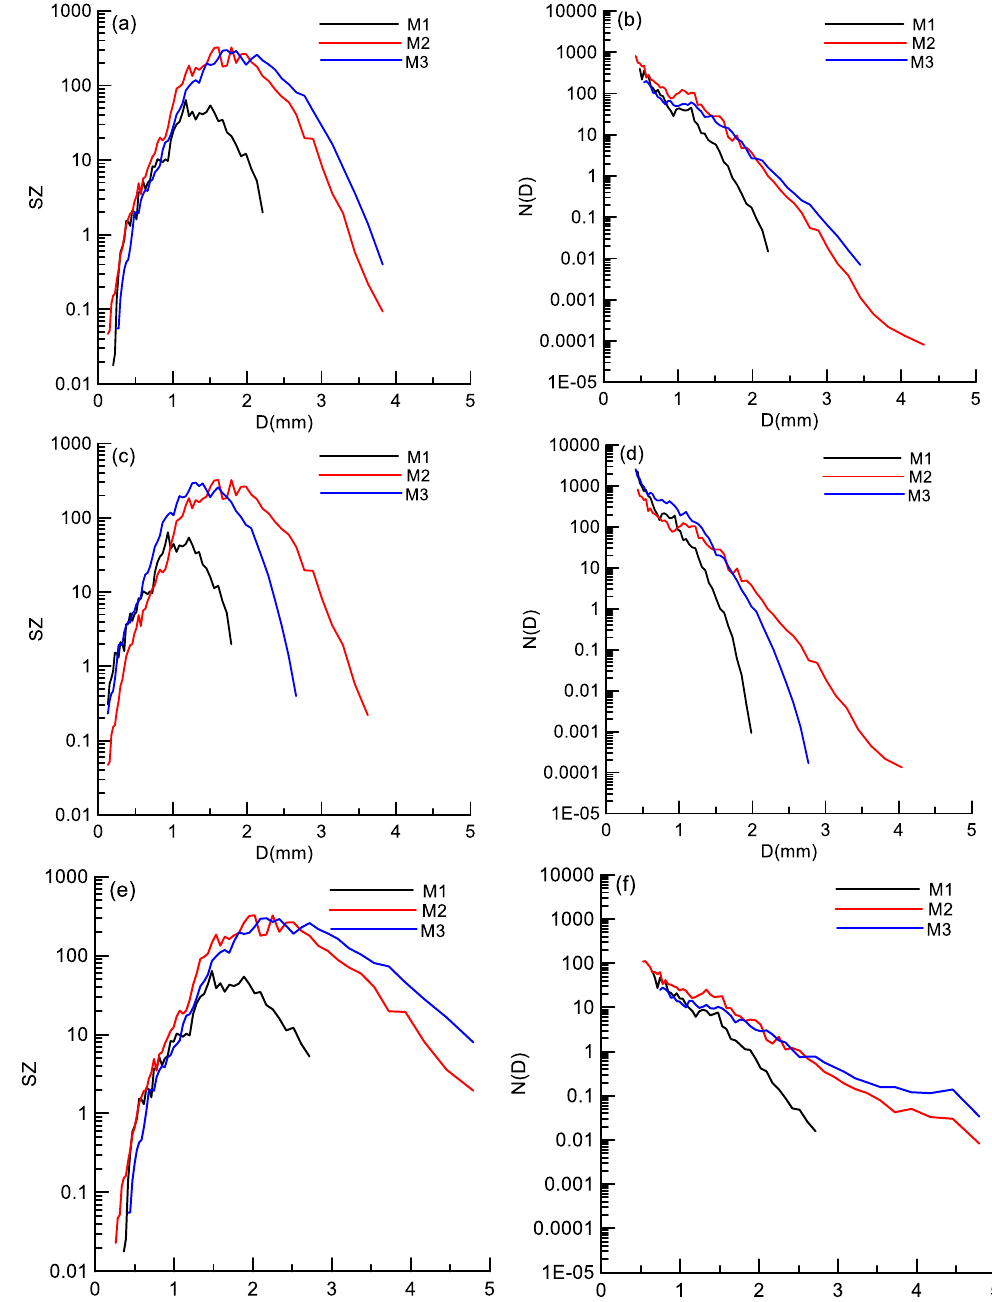
Figure 12. Processed reflectivity spectra (mm − 5 · m − 3 · s) and retrieved raindrop size distribution (DSD) (m − 3 · mm − 1 ) in ( a , b ) T1, ( c , d ) T2, and ( e , f )